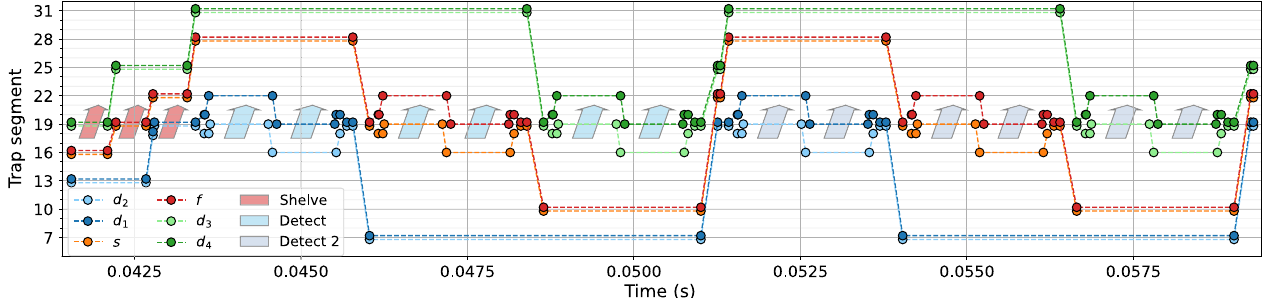
FIG. 13. Shuttling of the multiqubit readout sequence part described in Sec. B 3. The two-qubit building blocks sequentially undergo electron shelving (red arrows, up to 43 ms). Then, state-dependent fluorescence is detected after separating each pair (light blue arrows, up to 51 ms). Another round of detection is performed including qubit reset to verify register integrity (light blue arrows, up to 59